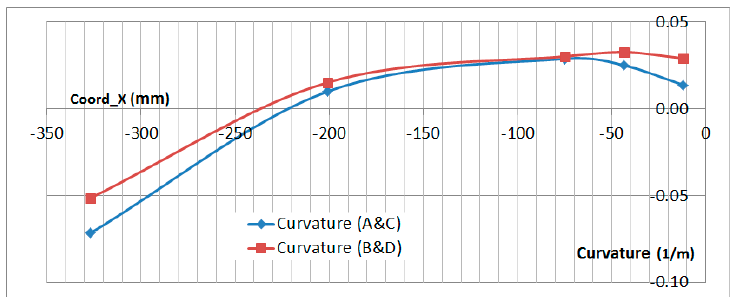
Figure 24. Calculated Curvature in Compression ( − 300 kN).